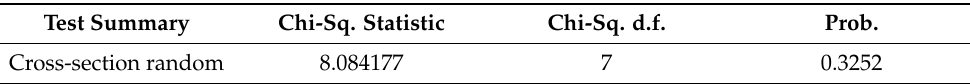
Table 6. Hausman test.